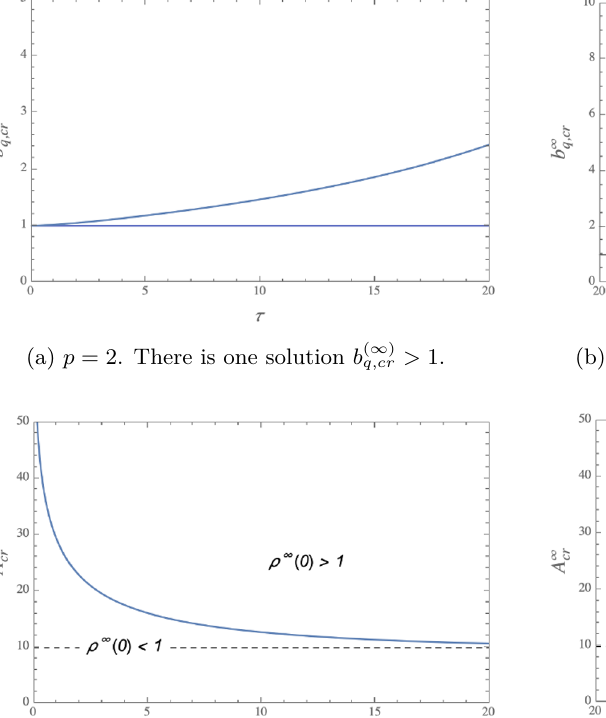
(c) p = 2 . Dashed line — π 2 . (d) p = 1 . A ( ∞ ) cr exists for τ > 22 . 06 . . . Figure 5. The solutions to the eq. (7.12) at p = 2 , 1 . The line A ( ∞ ) cr separates the one-cut phase (cid:0) (cid:1) ρ ( ∞ ) s A, p, 0 < 1 from the two-cut ρ ( ∞ ) s